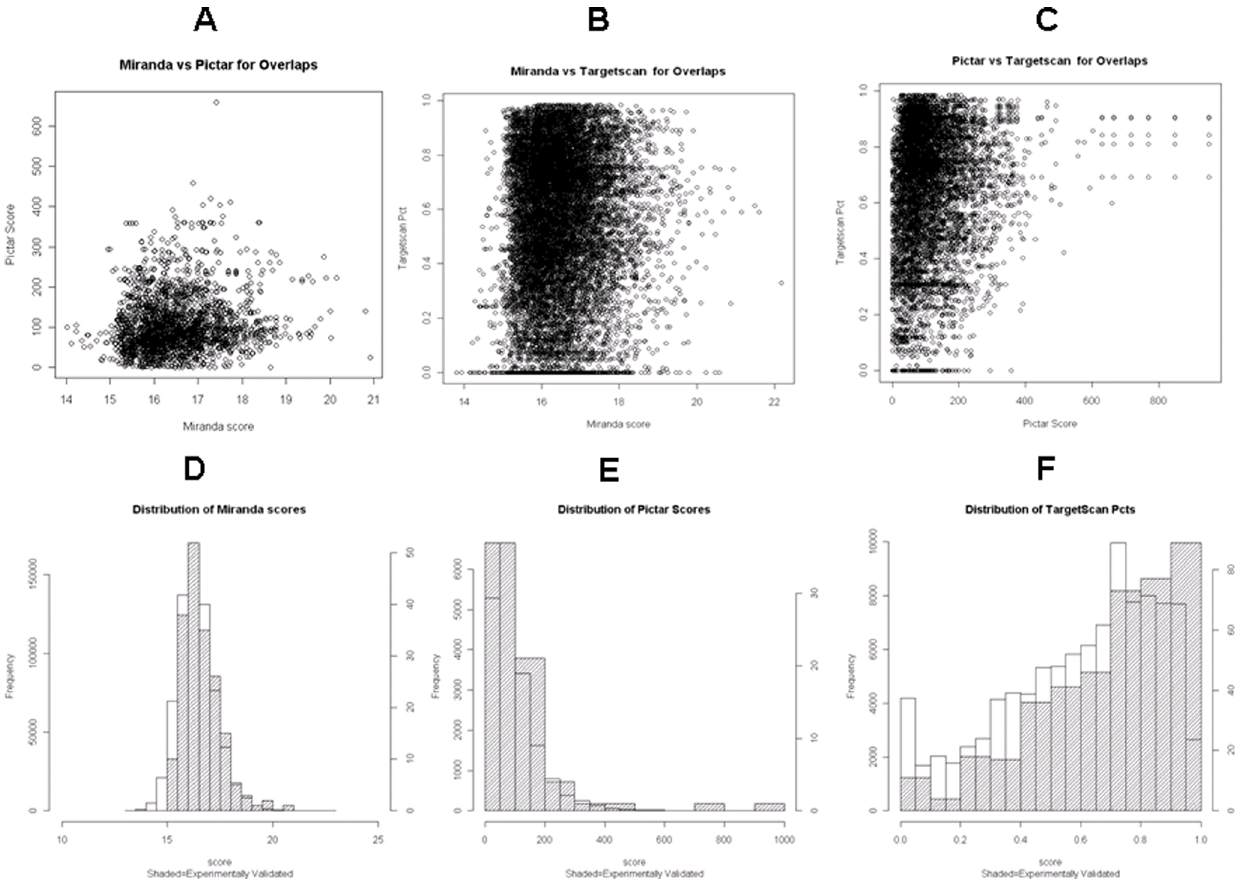
Figure 2. Prediction results from existing computational approaches are not correlated. Prediction scores (TargetScan, PicTar, and miRanda) for the same miRNA targets are plotted to show pair-wise comparisons (A, B, C). The distributions of scores for targets from the TarBase (experimentally-validated) are shown with the scores for the full set of targets from individual prediction algorithms (D, E, F). (A) miRanda (x-axis) scores are plotted against PicTar scores (y-axis); (B) miRanda (x-axis) scores are plotted against TargetScan scores (y-axis); (C) PicTar scores (x-axis) are plotted against TargetScan scores (y-axis); (D) Histogram of experimentally-validated targets with the distribution of miRanda scores (left y-axis is for the miRanda p values; right y-axis is for the TarBase targets); (E) Histogram of experimentally-validated targets with the distribution of PicTar scores (left y-axis is for the PicTar scores; right y-axis is for the TarBase targets); and (F) Histogram of experimentally-validated targets with the distribution of TargetScan scores (left y-axis is for the TargetScan scores; right y-axis is for the TarBase targets).